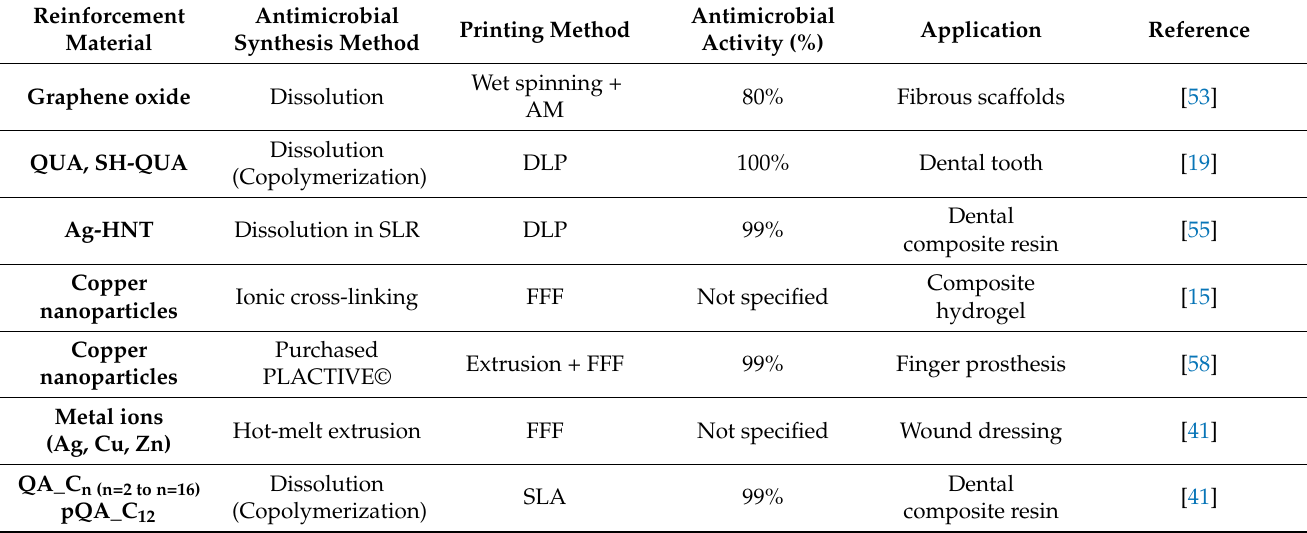
Table 3. Comparison of antibacterial efficacies from the abovementioned recent